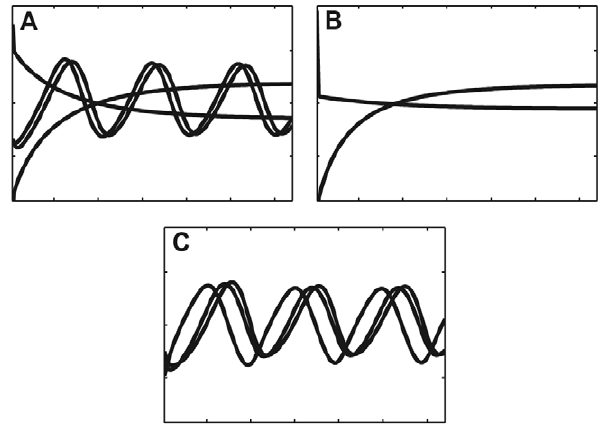
Figure 1. Three dynamic models with different dimensionality. A model with 4 variables, B model with 2 variables and C model with 3 variables. A has similarities with both B and C, however the distance between B and C is large. The question that SMETS addresses is which of B and C is closest to A?